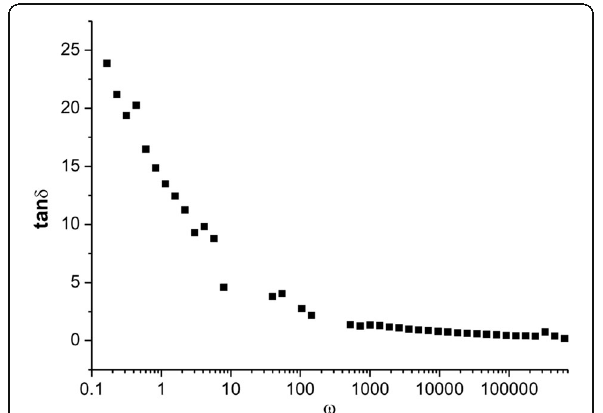
Fig. 9 Dielectric tangents loss dependence at 273 K